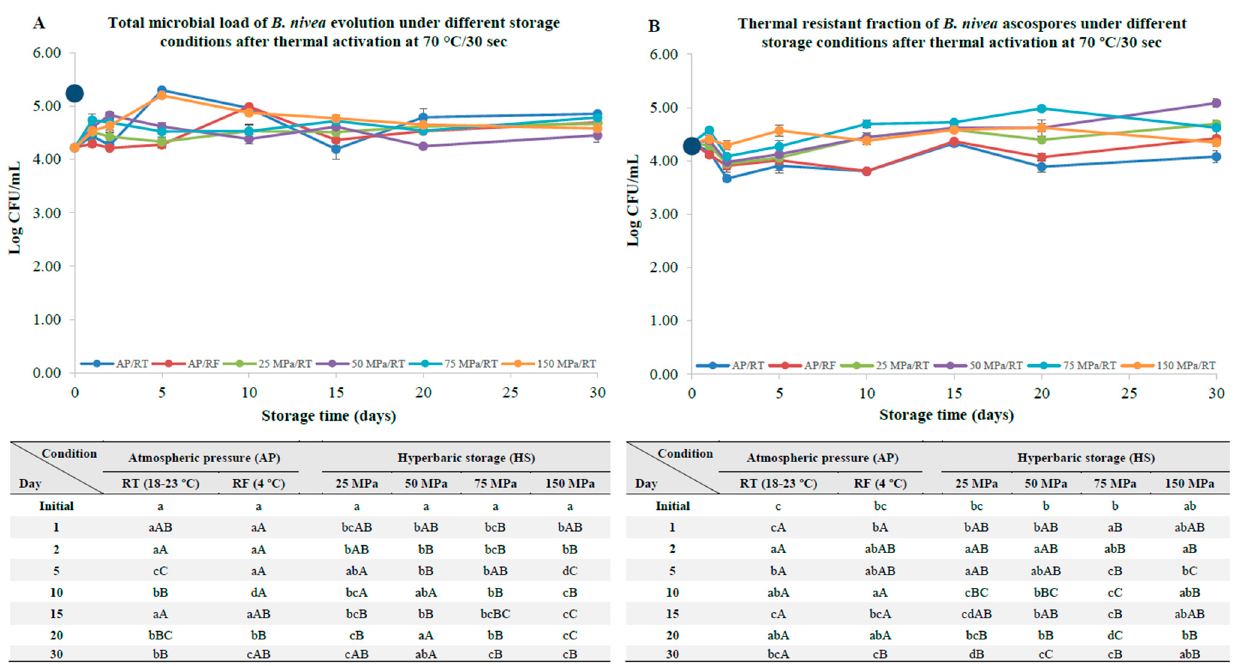
Figure 3. Total microbial load (unheated samples, ( A )) and thermal resistant ascospore fraction (heat-treated samples at 70 °C for 10 min, ( B )) of B. nivea in commercial apple juice (pH 3.7) stored at atmospheric pressure (AP) and naturally variable/uncontrolled room temperature (18–23 °C, AP/RT), AP and refrigeration (4 °C, AP/RF) and hyperbaric storage (25, 50, 75 and 150 MPa, HS) at naturally variable/uncontrolled RT, without a thermal activation step at 70 °C for 30 s. Different lower-case letters (a–e) indicate significant differences ( p < 0.05) between storage days, while different upper-case letters (A–C) indicate significant differences between storage conditions (for a given day). The dark and larger circle at the Y axis represents the initial load before the thermal activation step at 70 °C/30 s. The dark blue circle at the Y axis represents the initial load before the thermal activation step at 70 °C/30 s.